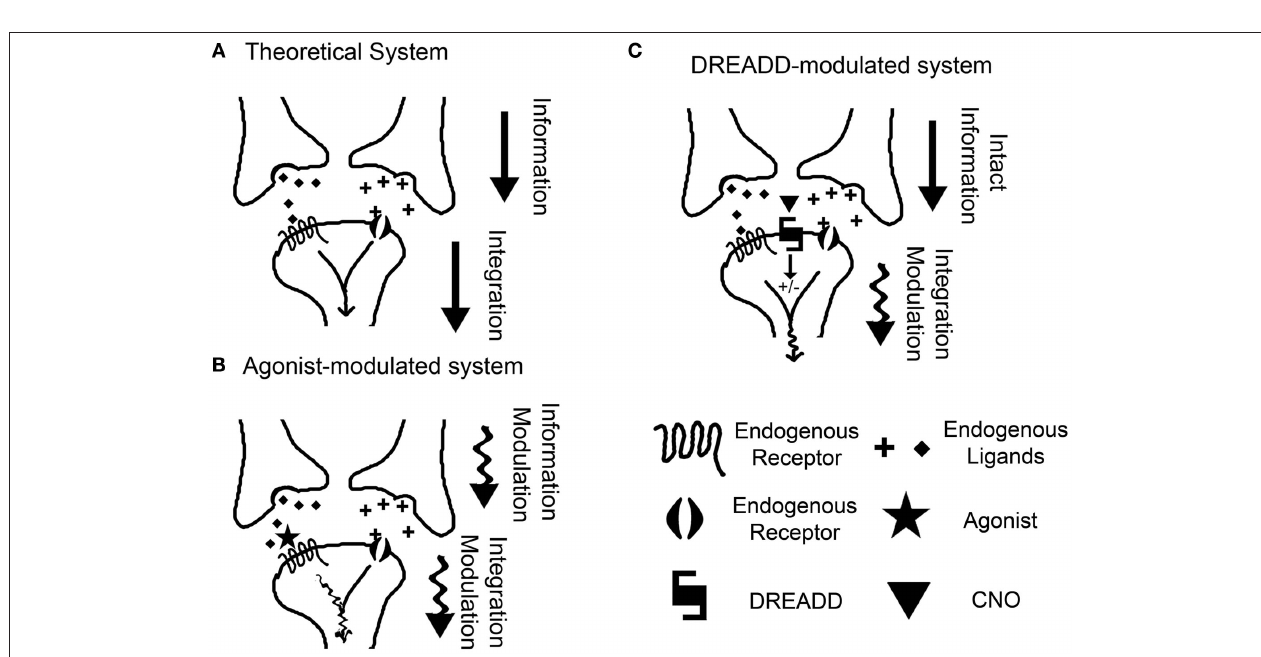
information. Instead, the agonist simultaneously interferes with the endogenous neurotransmitter tone, thus manipulating the information itself. (C) Using a DREADD, modulation of the post-synaptic neuron is achieved exclusively, leaving the information intact. This allows direct investigation of the mechanisms of